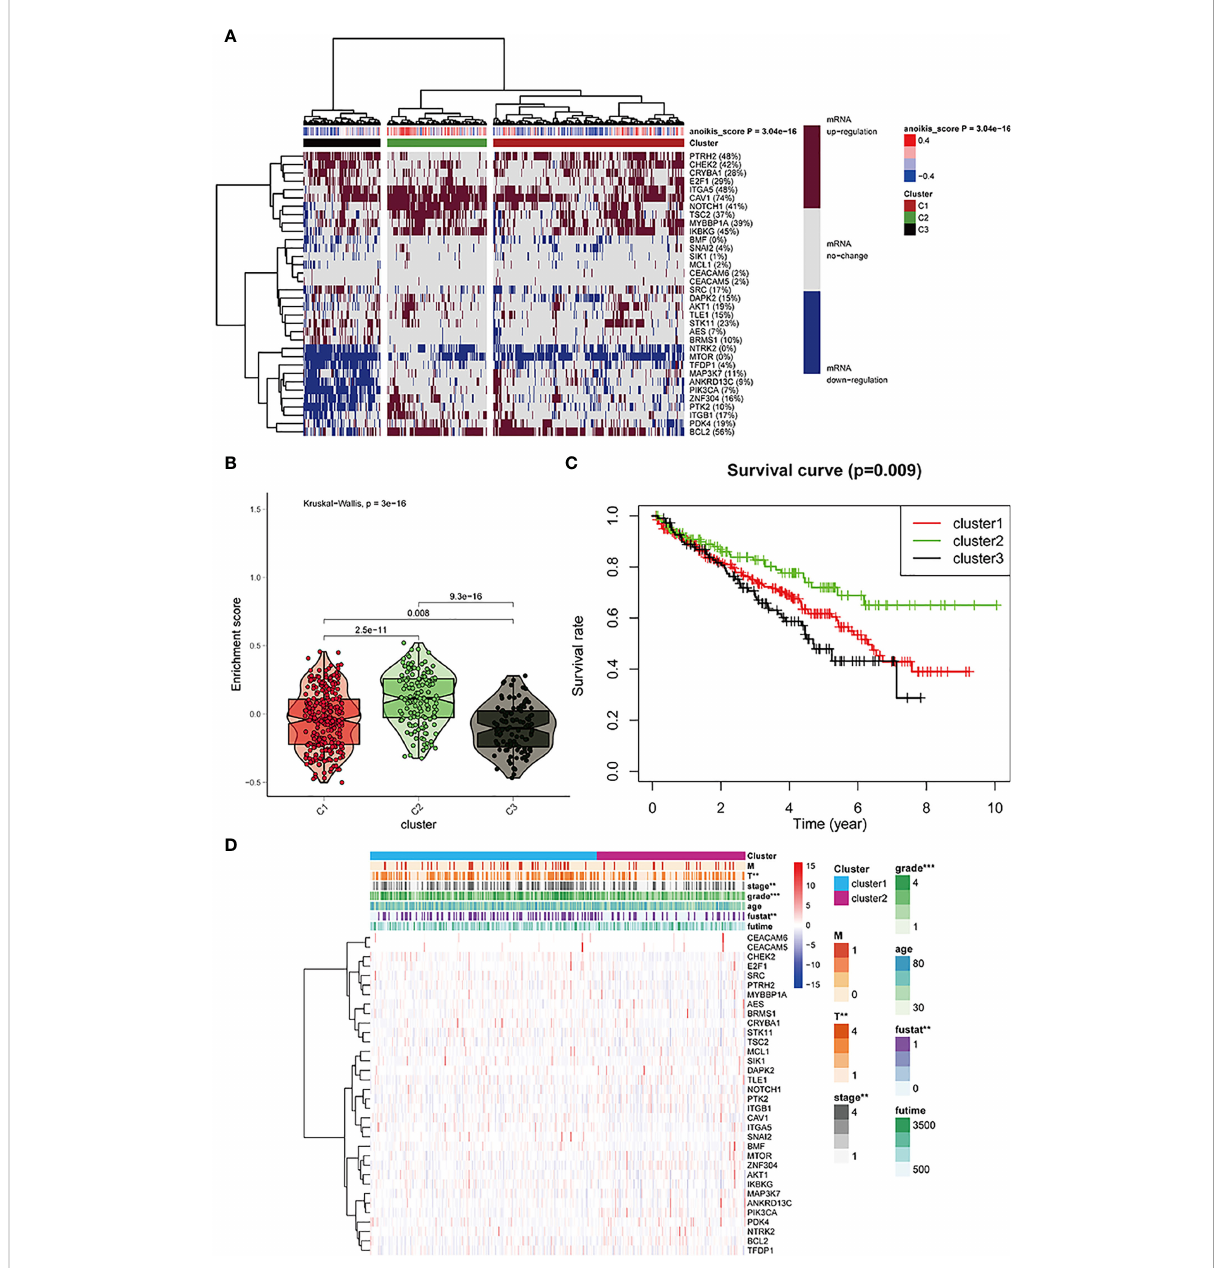
FIGURE 2 (A) All KIRC samples are divided into three groups according to different levels of anoikis score: high/medium/low expression group (cluster1, 2, and 3). The dark red/blue represent mRNA expression increased/decreased, respectively. The redder/bluer the color, the closer the anoikis score is to 0.4/-0.4, respectively. Three groups divided through cluster analysis: red/olive green/black represent clusters 1,2, and 3, respectively. (B) The enrichment scores of the three clusters. The color differentiation was the same as Figure 2A. (C) Survival curves are based on three clusters. (D) The correlation between anoikis scores and the clinicopathological characteristics of KIRC patients. *p < 0:05, **p < 0:01, and ***p <